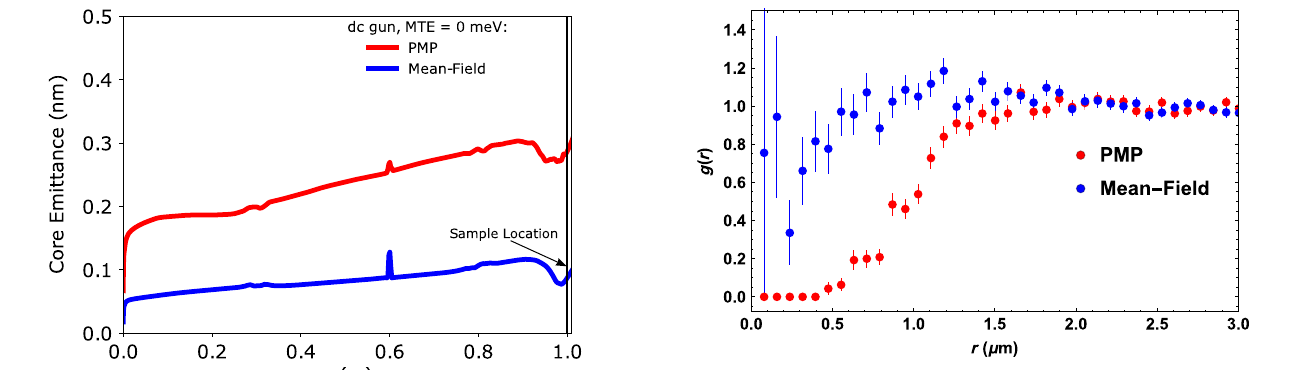
FIG. 8. Core emittance comparison between PMP and mean- field simulations of the dc UED beam line with 0 meV MTE.